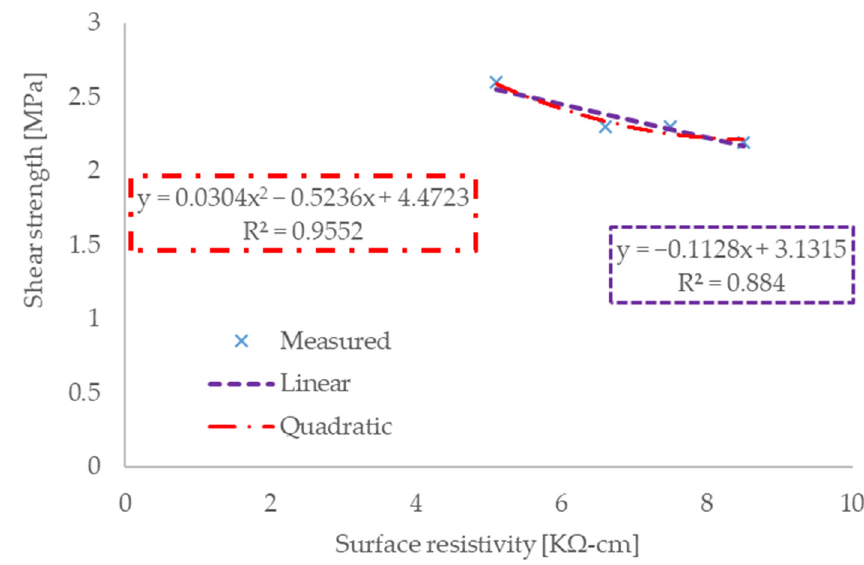
Figure 12. The relationship between surface resistivity and shear strength.